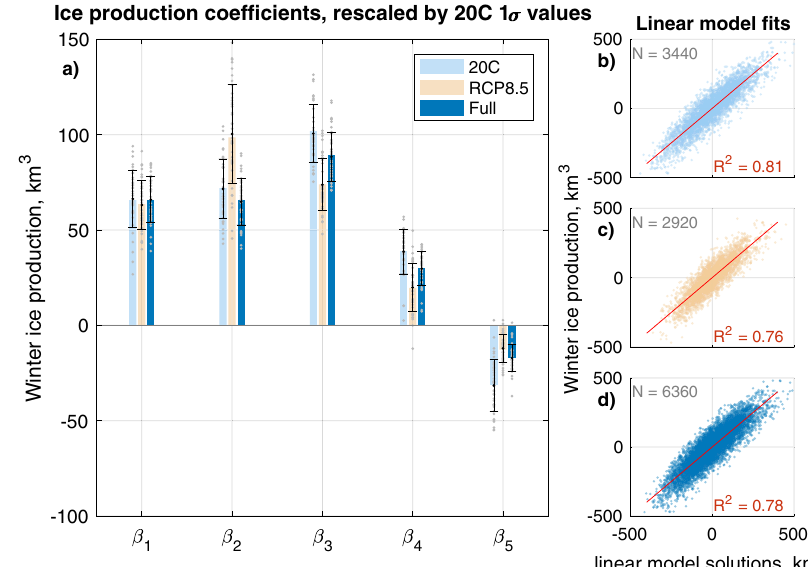
Fig. 5 | A linear model for ice production. a Winter ice production regression coef fi cients, standardised by the respective one standard deviation values in the 20C run. Coloured bars show the regression coef fi cients calculated using internal variability across all 40 ensemble members, with the ensemble mean removed, in the 20C (light blue), RCP8.5 (orange) and full (dark blue) datasets, respectively. Grey points indicate the regression coef fi cients as calculated using the deviations from the ensemble meanin individualmodels and indicate uncertainty. Black dots indicatethemeanofthe40estimatesandwhiskersindicateonestandarddeviation